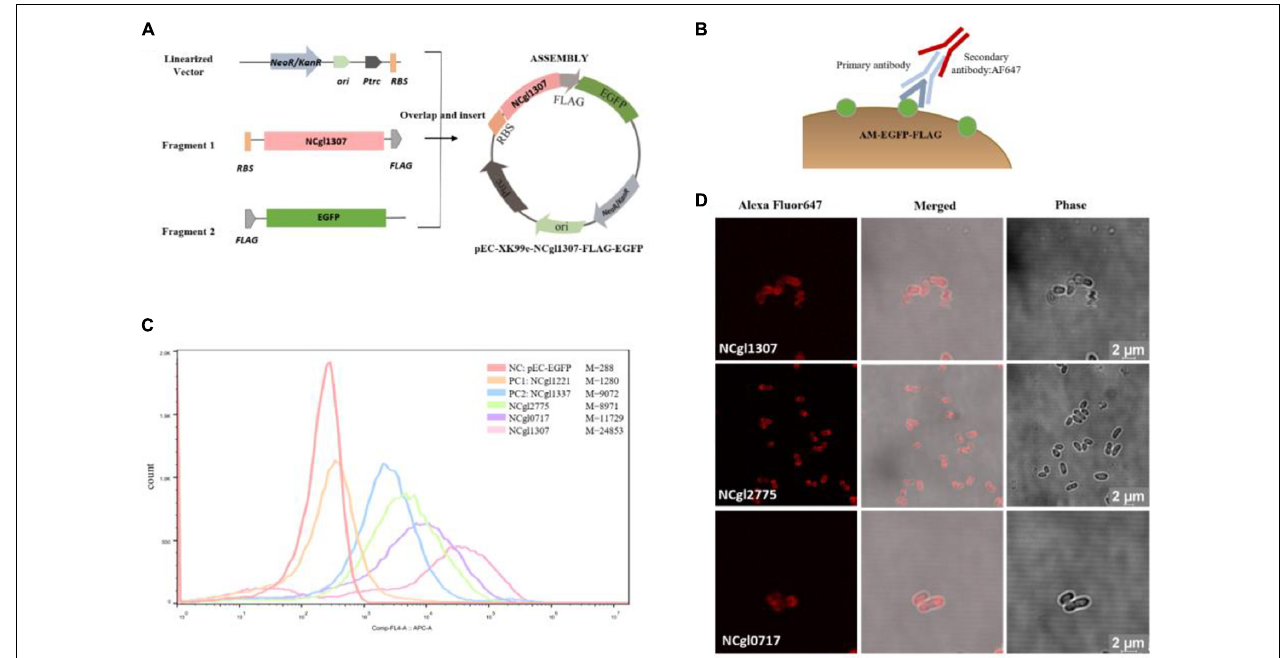
FIGURE 1 | Screen and confirmation of anchoring protein display on the cell surface by displaying EGFP. (A) Construction of recombinant Corynebacterium glutamicum surface display plasmid with EGFP as passenger protein. The construction of all the expression vectors of passenger protein EGFP was constructed using the same cloning strategy with a different PCR primer set. Take the construction of Ncgl1307-EGFP as an example. Using the genomic DNA of C. glutamicum ATCC13032 as a template and using 5am F and 5am R as primers, the Ncgl1307 gene sequence fragment 1 was amplified by PCR; using the EGFP gene as a template and using EGFP F-N site and EGFP R-N site as primers, the target protein EGFP gene fragment 2 was amplified; using pEC-XK99e as a template and pEC F and pEC R as primers, the gene sequence linearized vector of pEC-XK99e was amplified. Finally, this three fragments were assembled into a plasmid by Seamless Assembly Cloning Kit. (B) Schematic diagram of the immunofluorescence reaction. Anti-flag monoclonal antibody and Alexa Fluor 647-labeled antibody were added to the EGFP-FLAG. (C) Flow cytometry analysis. The peak figures of different colors from left to right represent the fluorescent signal intensities of cells harboring pEC-EGFP, Ncgl1221-EGFP, Ncgl1337-EGFP, NCgl2775-EGFP, NCgl0717-EGFP, or NCgl1307-EGFP, respectively. Of these, cells harboring pEC-EGFP were the negative control (NC − EGFP ), and cells harboring Ncgl1221-EGFP and Ncgl1337-EGFP were the positive control 1 (PC1 − EGFP ) and the positive control 2 (PC2 − EGFP ), respectively. M is mean value of Comp-FL-A:APC-A_Area. (D) Image observed on a confocal microscope based on immunofluorescence reaction. The red fluorescence comes from the fluorescence of the Alexa Fluor 647-labeled antibody on the flag label (667 nm—excitation, 651